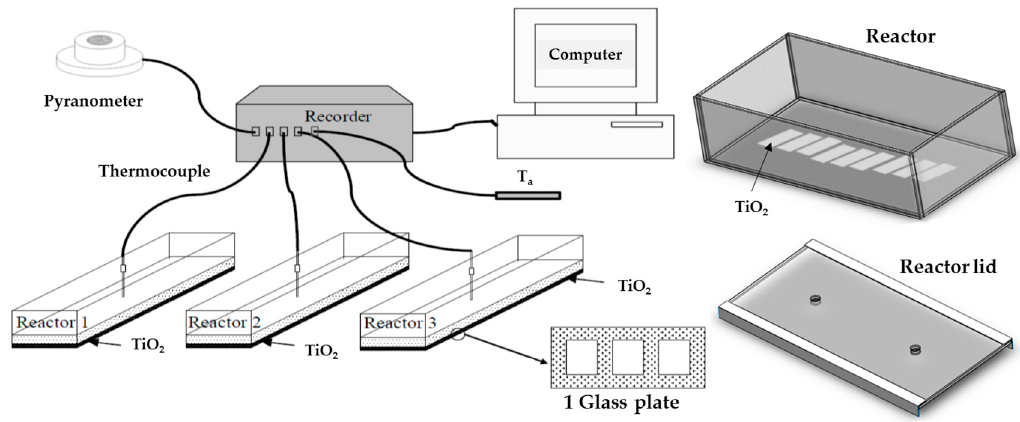
Figure 7. Schematic drawing illustrating connections of the experimental devices employed in the study of inactivation of bacteria.